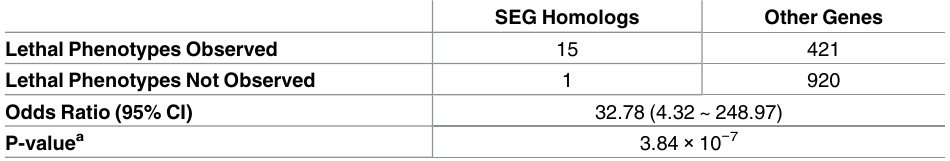
Table 3. The association between SEGs knockout and lethal